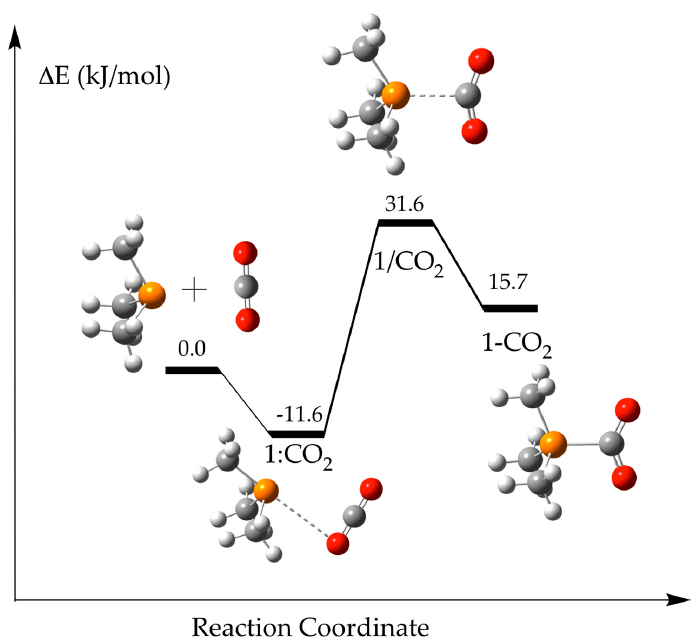
Figure 3. Optimized stationary points along 1 + CO 2 energy profile using continuum polarizable method (PCM)-chloroform solvent model.